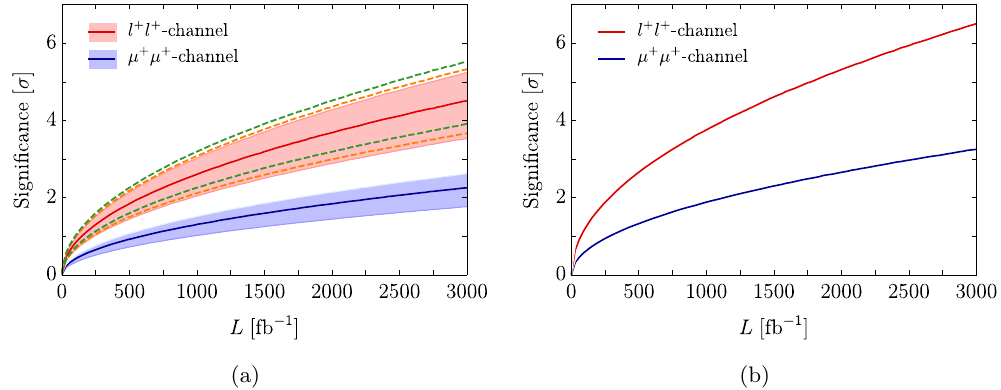
Figure 16 . (a) Estimate of the signi(cid:12)cance of the asymmetry of 0.11 from zero for a signal cross section of 0.29 fb, as the distance in standard deviations. Blue line/band corresponds to (cid:22) + (cid:22) + only while the red line/band includes all positively charged combinations of two light leptons ( e + and (cid:22) + ). Dashed curves show the sensitivity of the central red curve to changes of the asymmetry by 20% (orange dashed curves) and the magnitude of the DPS cross section by a factor of 3 = 2 or 3 = 4 (green dashed curves). (b) Estimate of the signi(cid:12)cance of the asymmetry of 0.11 from the pos-pol value of -0.05. Blue line corresponds to (cid:22) + (cid:22) + only while the red line includes all positively charged combinations of two light leptons ( e + and (cid:22) +